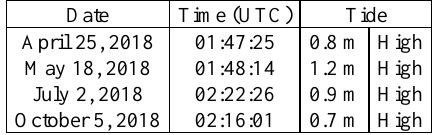
Table 4. Time of Acquisition and Tides of PlanetScope Ortho Tile Images